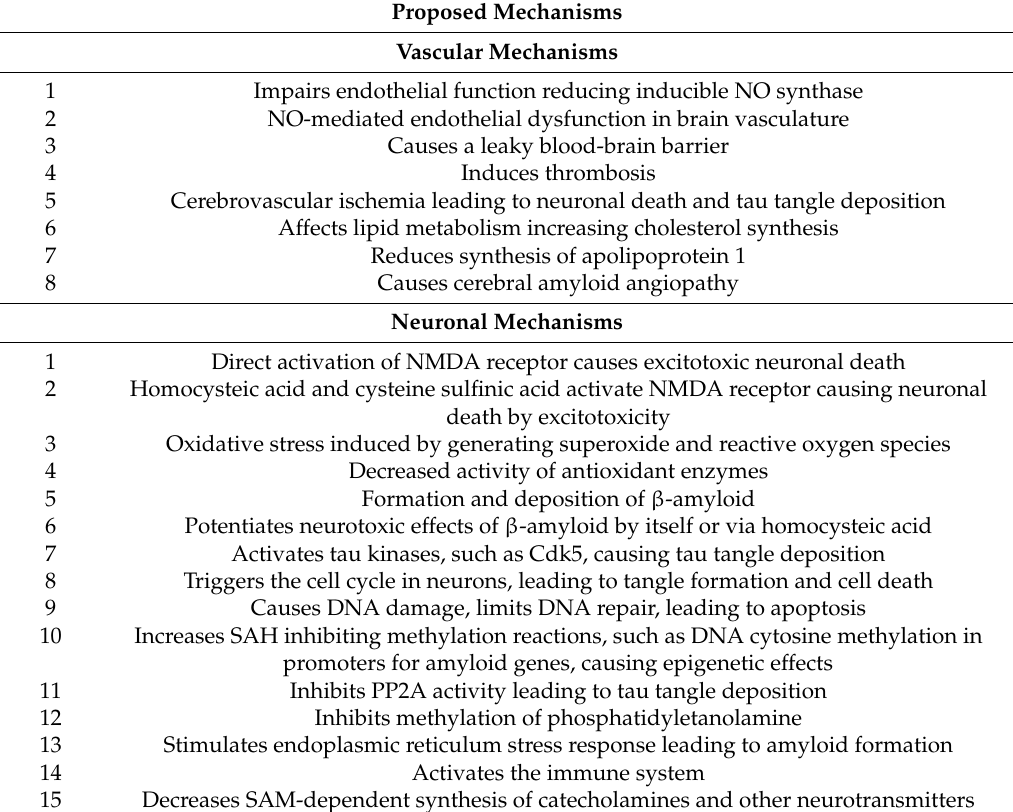
Table 1. Harmful effects of homocysteine on vascular function and cognition (modified from Smith & Refsum